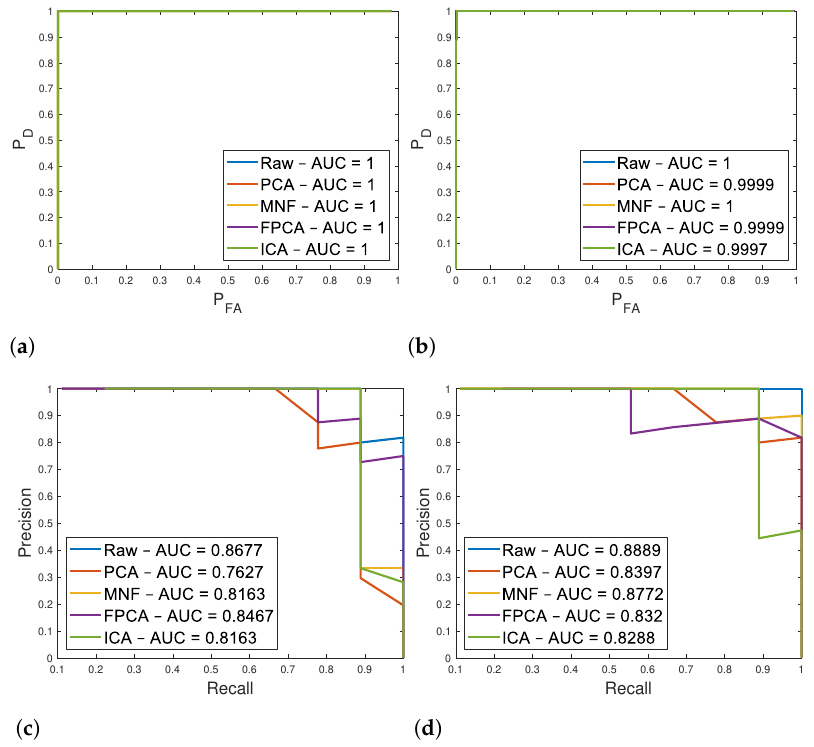
Figure 12. ROC and PR curves for detecting Target 1 (grey tile) in the OP7 dataset ( a ) ROC curve using the full spatial dimensionality data. ( b ) ROC curve using spatial DR pre-processing. ( c ) PR curve using the full spatial dimensionality data. ( d ) PR curve using spatial DR